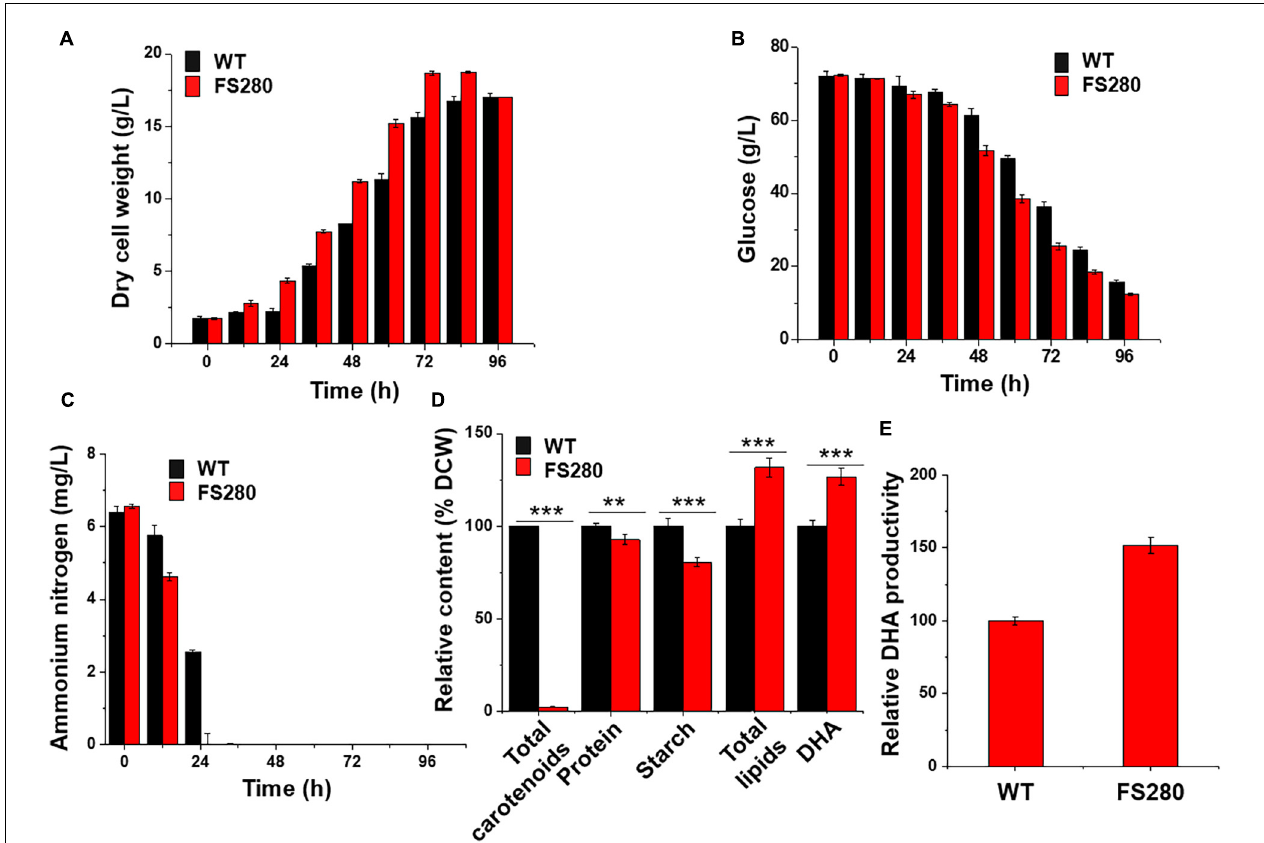
FIGURE 3 | Comparative characterization between FS280 and WT without the fermentation supernatant. (A) Changes in dry cell weight. (B) changes in glucose concentration. (C) Changes in ammonium nitrogen concentration. (D) Relative content of cell components at 72 h. (E) Relative DHA productivity at 72 h. ** p < 0.01 and *** p <